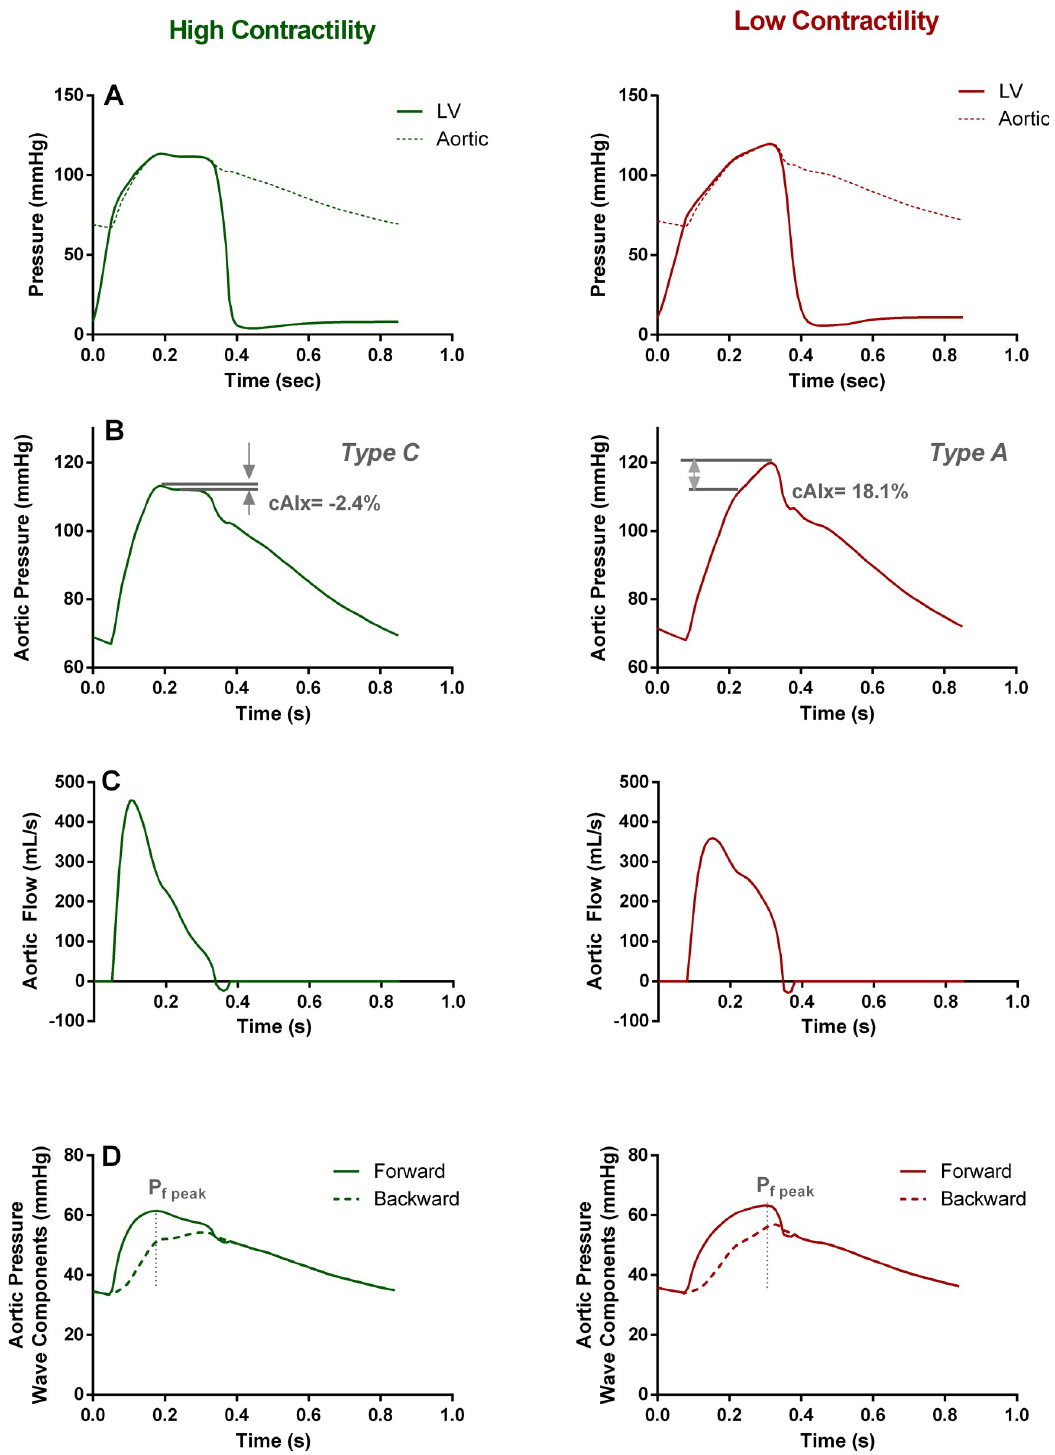
Fig 3. Effect of LV contractility on central hemodynamics. ( A) LV and aortic pressure as a function of time. (B) Characteristic Type C and Type A aortic pressure phenotypes reproduced by high and low contractility, respectively. (C) Aortic flow. (D) Forward and backward travelling pressure waves. Note that the forward peak occurs significantly earlier in the high contractility simulation, while the amplitudes of the forward and backward pressure waves are left